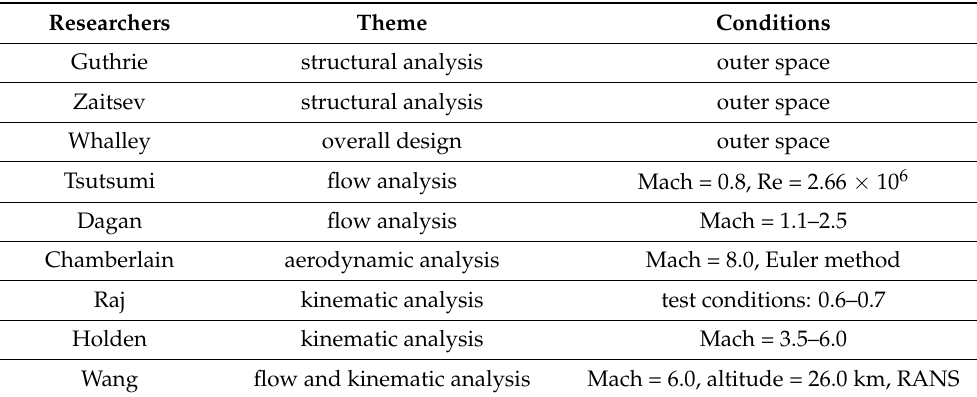
Table 2. Research status of shroud